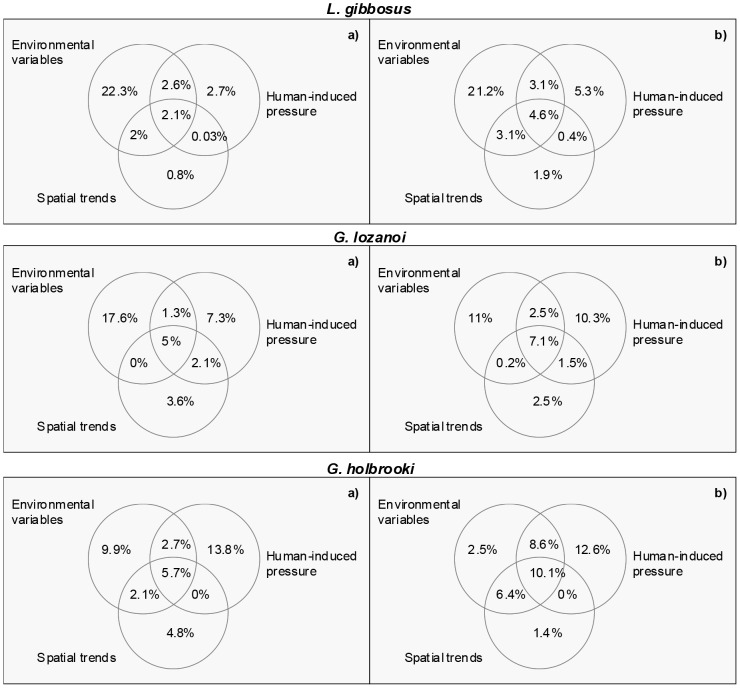
Veen diagrams showing the partition of the variance in the occurrence (a) and mean density (b) of the most abundant NNS explained by environmental variables, human-induced pressure and spatial trends.